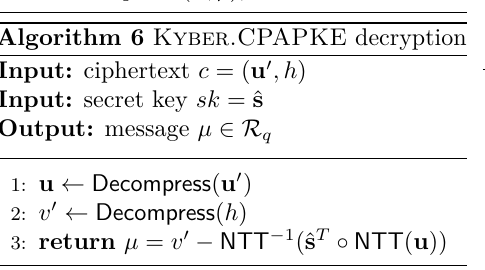
Algorithm 6 Kyber.CPAPKE decryption